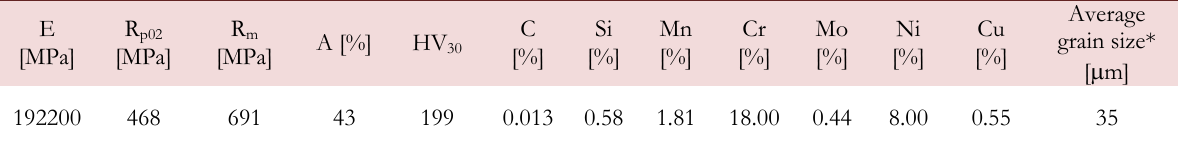
Table 1: AISI 304 L material properties (*According to ASTM E 112 [21]).